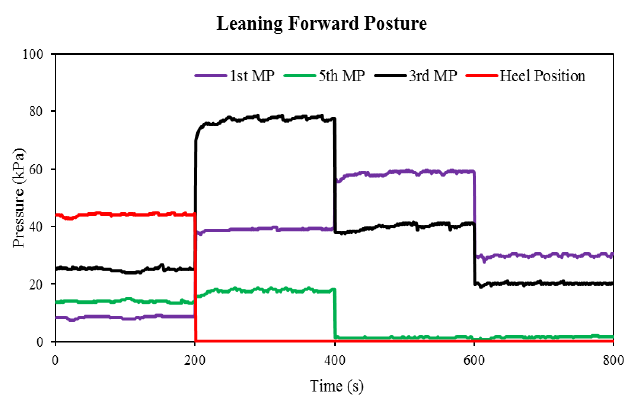
Figure 6. During the leaning forward, the posture pressure changes of Flexi force sensors over time.